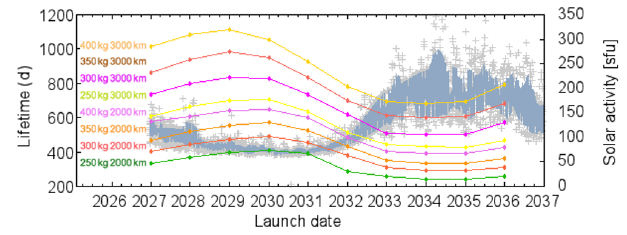
Figure 5. Simulated Daedalus lifetimes as a function of launch date for a perigee of 150km and for various values of apogee and space- craft mass, as marked. It is noted that higher mass and apogee lead to longer lifetimes, whereas higher levels of solar activity lead to shorter lifetimes. Solar activity is plotted in terms of daily (gray crosses) and average (gray lines) values of the F10.7